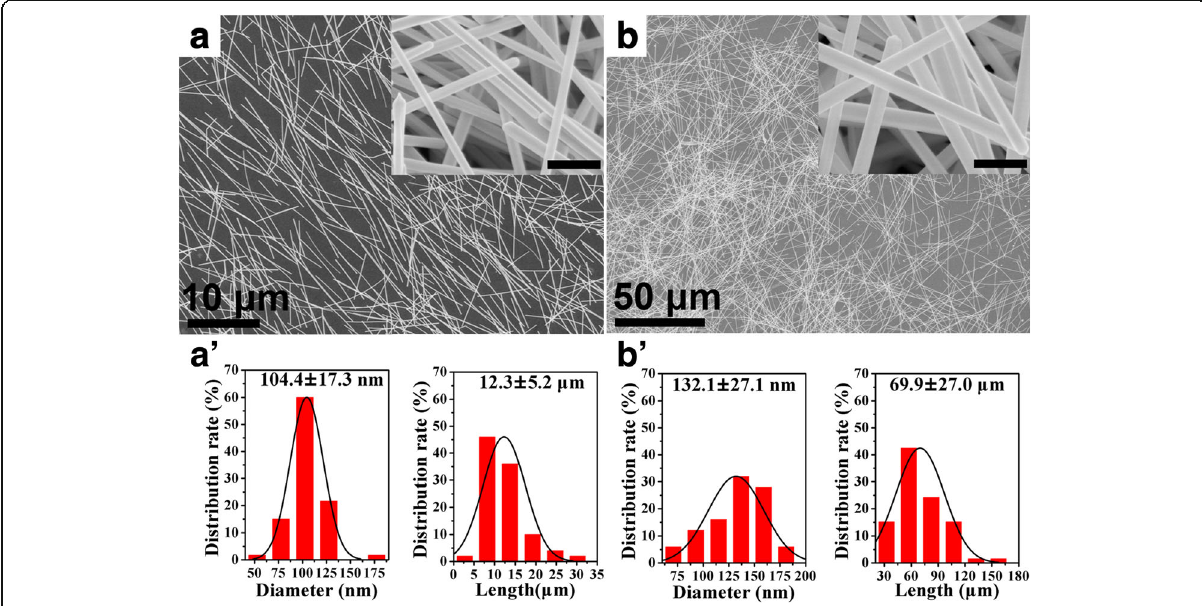
Fig. 1 a , b SEM images of as-synthesized Ag NWs with PVP-40 and PVP-360, respectively. Both the concentration of PVP are 0.15 M. a ′ b ′ Corresponding statistical distribution of diameter and length. (The insets in a and b are the corresponding SEM images with high magnifi- cation and all the scale bars are 500